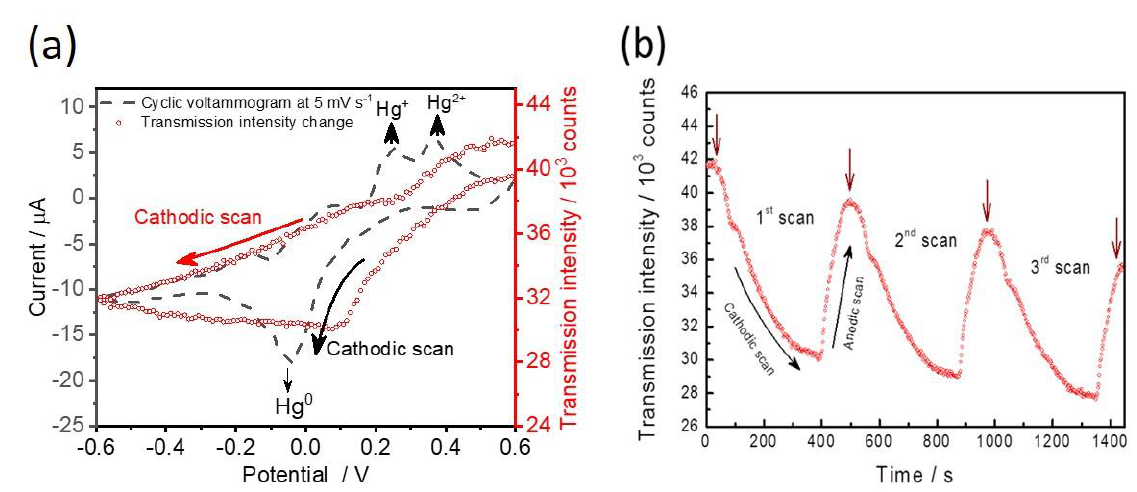
Figure 4. ( a ) Redox current curves during the first cyclic voltammetry scan and the simultaneously measured SPR intensity. The filled squares indicate current and the open diamonds indicate SPR intensity. ( b ) The changes of SPR intensity during three cyclic voltammetry scans. Brown arrows point out the transmission intensities at +0.6 V for each cycle. Electrolyte: 100 μM Hg 2+ in 10 mM KCl solution. Scan rate: 5 mV s −1 .